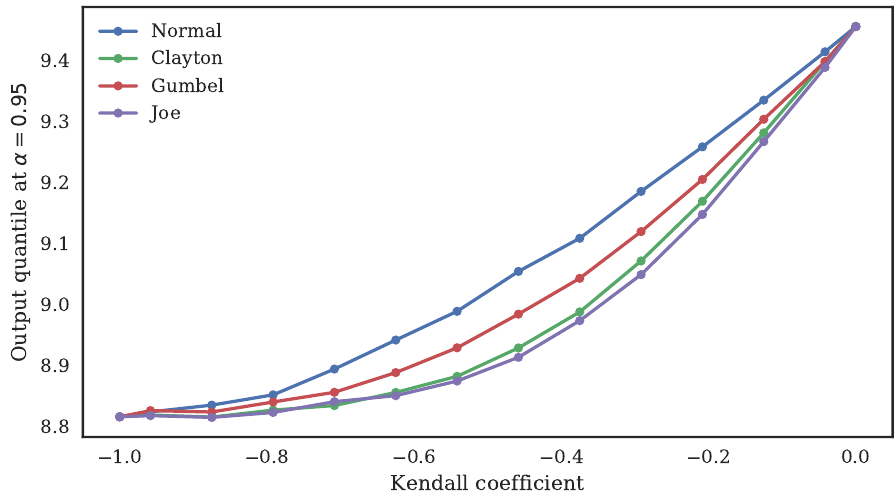
Figure 12: Variation of the quantile of the overflow distribution with the Kendall coefficient τ for α = 95% and different copula families (Gaussian, Clayton, Gumbel and